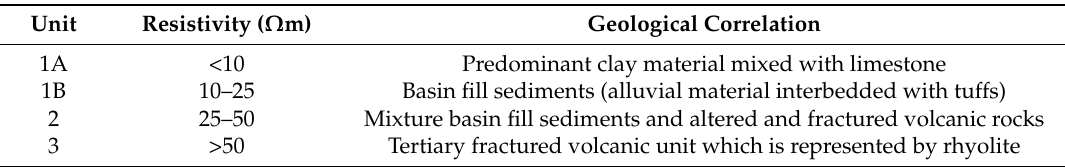
Table 5. Geoelectrical units and their geological